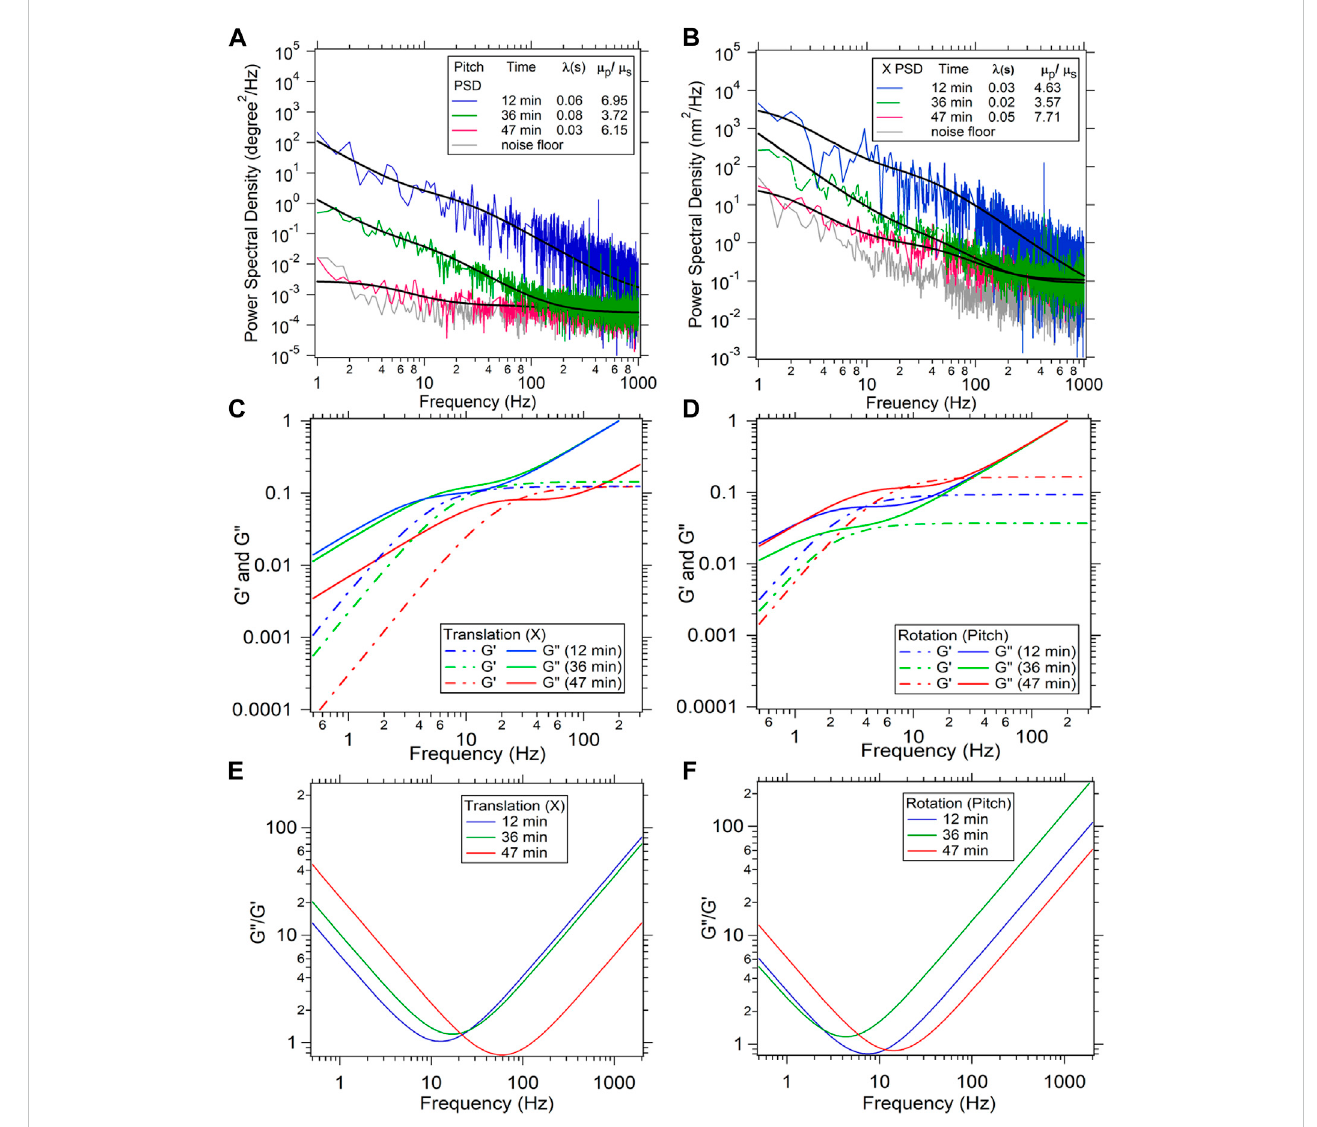
FIGURE 4 A time dependentmeasurement of viscosity ratio μ p μ and relaxation time λ for translation(X) (A) and corresponding pitch (rotation) (B) of thesame particle s at same instant of time is shown. Time mentioned here is the duration since start of the experiment, when the healthy cell is placed onto the stage at 25 C roomtemperature.FittoEq.4isshownwithblacksolidlines. (C) and (D) Storagemodulus(G ’ )andlossmodulus(G ” )forXandPitchforthethreedifferentPSDs is shown for translation and rotation (E,F)